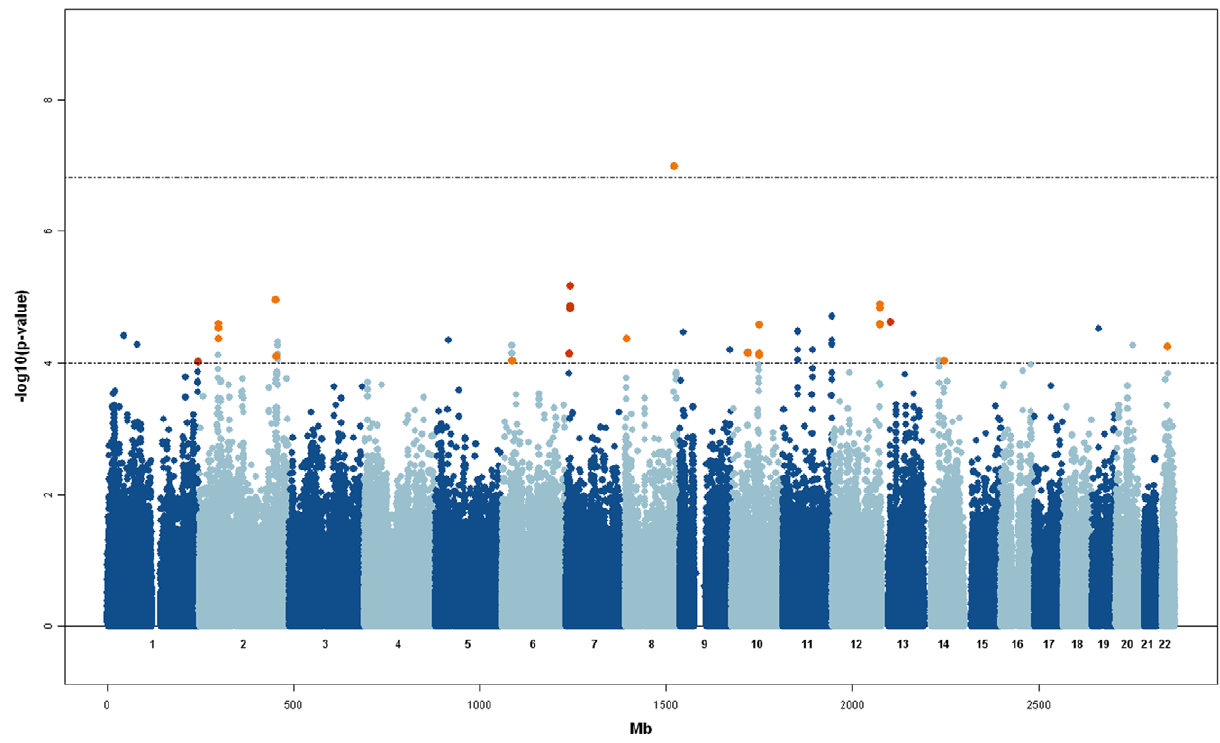
Figure 2. Manhattan plot for the R x statistic. Orange points above the 2 log 10 (p-value) . 4 threshold indicate SNPs that have a p-value , 1E-2 for the R M statistic. Significant threshold after Bonferroni correction is shown. doi:10.1371/journal.pgen.1001281.g002 PLoS Genetics |